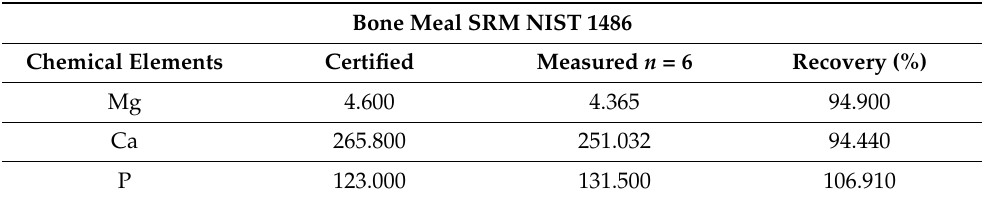
Table 1. Table analysis of NIST-SRM 1486 (Bone Meal)